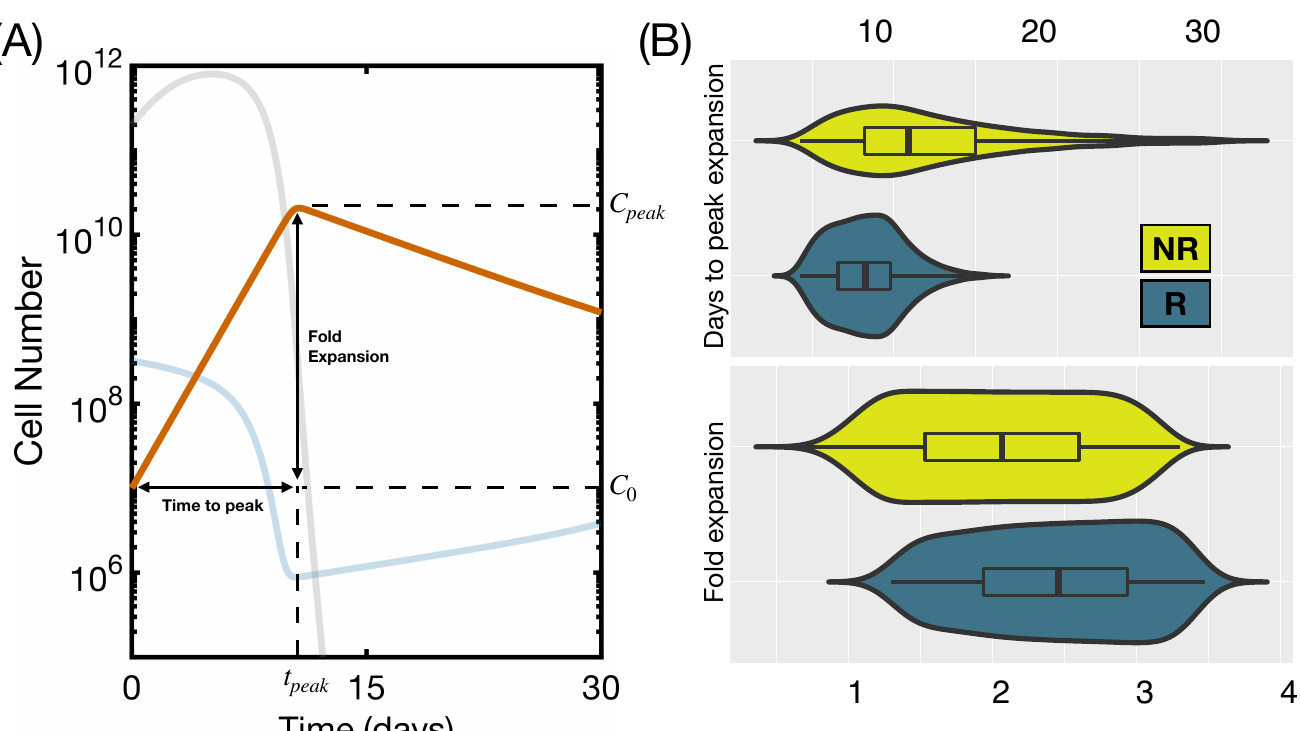
Figure 7. Characteristics of product expansion for Responding (R) and Non-Responding (NR) patients. ( A ) graphical representation, on a typical simulation, of the characteristics of the product expansion; ( B ) differences in time to peak and fold expansion for 4000 simulated patients with parameters from Table 1 and α in the range 5 × 10 − 11 –5 × 10 − 9 day − 1 · cell − 1 , h in the range 5 × 10 9 –5 × 10 11 cells and ρ C in the range 0.4–1 day − 1 . Initial state was set to B 0 ( 0 ) = 10 6 cells, B 1 ( 0 ) = 3 × 10 7 cells, B 2 ( 0 ) = 2 × 10 8 cells, B 3 ( 0 ) = 9 × 10 7 cells, L ( 0 ) = 2 × 10 11 cells, C A ( 0 ) = 5 × 10 7 cells and C M ( 0 ) = 0 cells. The boxplot shows median and first and third